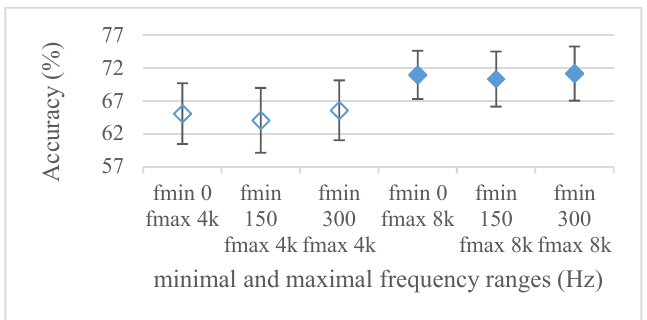
Figure 9. Averaged accuracies and standard deviations in case of Mel scale for minimal and maximal frequency limits; Fmin {0+, 150, 300 Hz}, Fmax {4, 8 kHz}, and no pre-emphasis. Filled marks show equally performing settings.